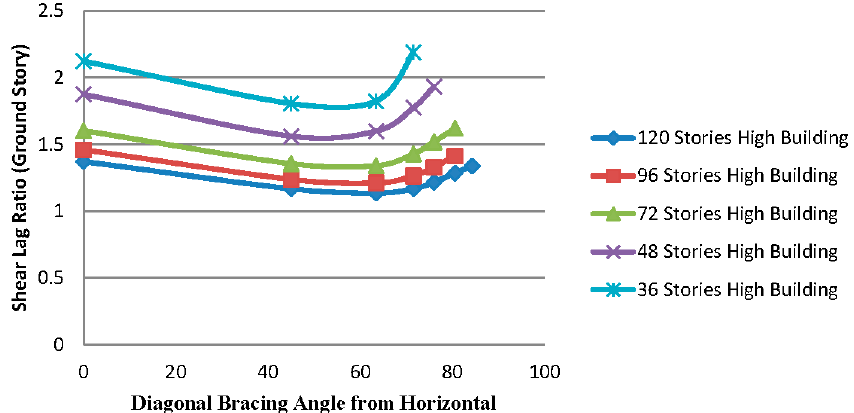
Figure 18. Top lateral deflection vs. varying angles of bracing systems for buildings of Model 4.